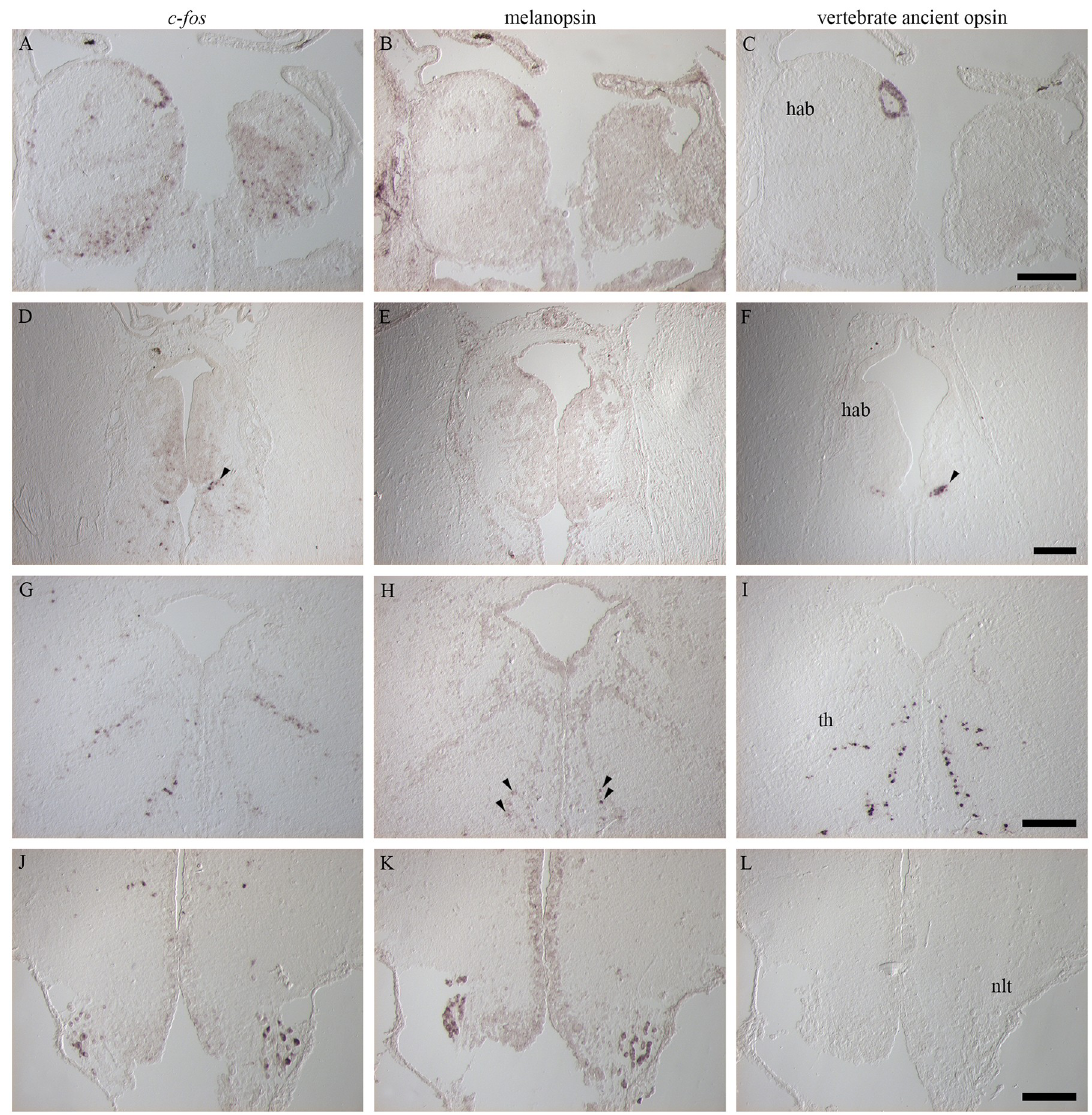
Fig 5. Comparison between activated brain regions, melanopsin and vertebrate ancient opsin (VA opsin) expression following exposure to different narrow bandwidth light treatments. A-C: In the left habenula (hab) a similar ring of cells was seen for c-fos (A), melanopsin (B) and VA opsin (C). D-F: Ventral of the caudal habenula, a small cluster of cells was detected for c-fos (D) and VA opsin (F) (see arrowheads) but not for melanopsin (E). G-I: In the caudal thalamus (th), a similar expression pattern was seen for c-fos (G) and VA opsin (I) and some melanopsin positive cells (H) (see arrowheads) were also detected. J-L: In the hypothalamus, the lateral cells of the lateral tuberal nucleus (nlt) expressed c-fos (J) after light activation and also melanopsin (K) but not VA opsin (L). Scale bars of 200 μ